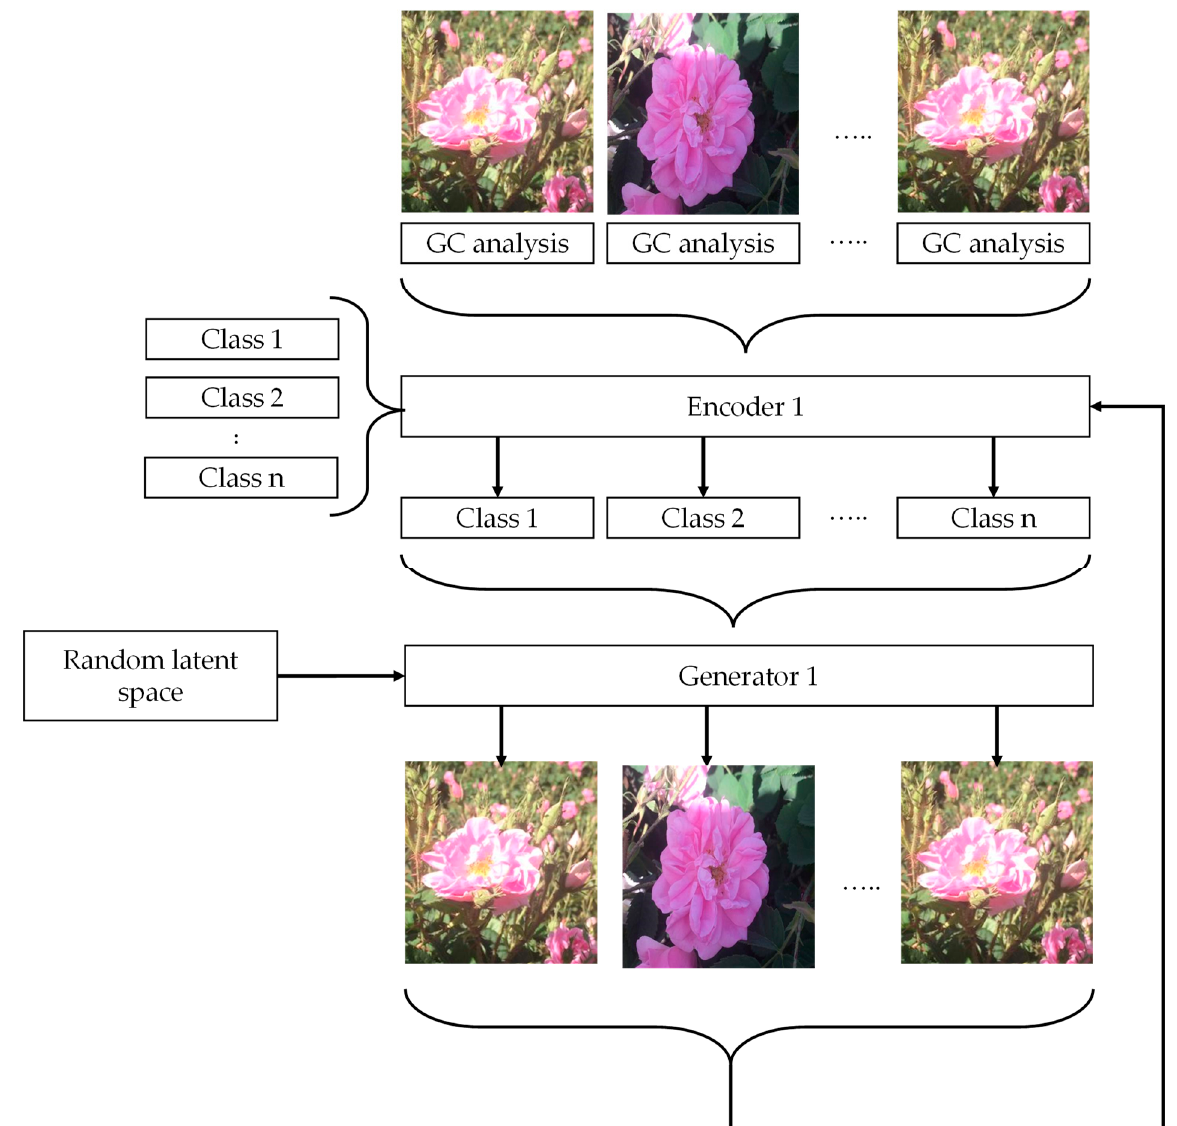
Figure 3. A schematic diagram of the proposed cSGAN model used in this study.